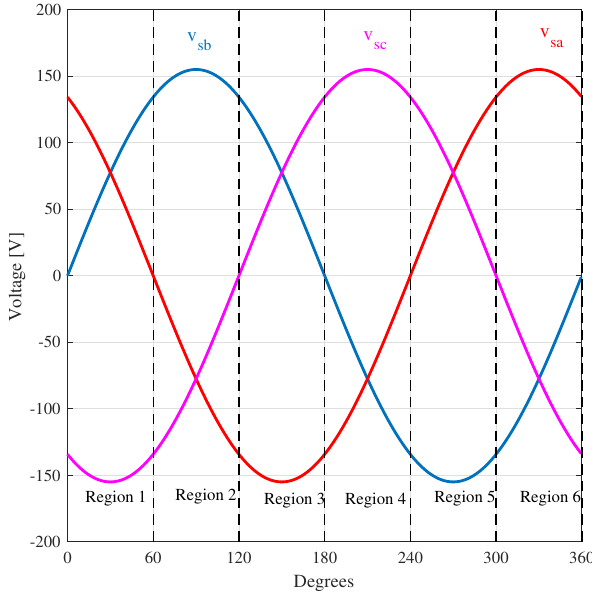
Figure 4. Three-phase grid voltages and sixty degrees